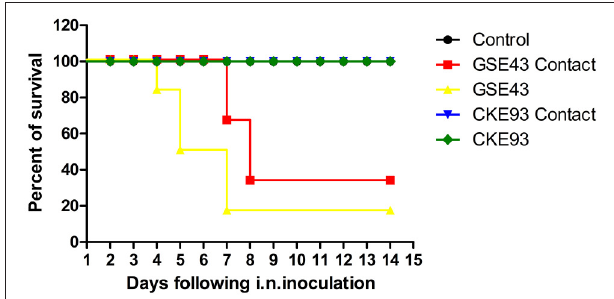
FIGURE 9 | Lethality of the A/GS/CN/E43/2012 and A/CK/CN/E93/2012 viruses in SPF chicken. Death patterns of the SPF chicken infected with A/GS/CN/E43/2012 and A/CK/CN/E93/2012 viruses with the doses of 10 3 EID 50 . Curves are significantly different ( P < 0.05) by log-rank